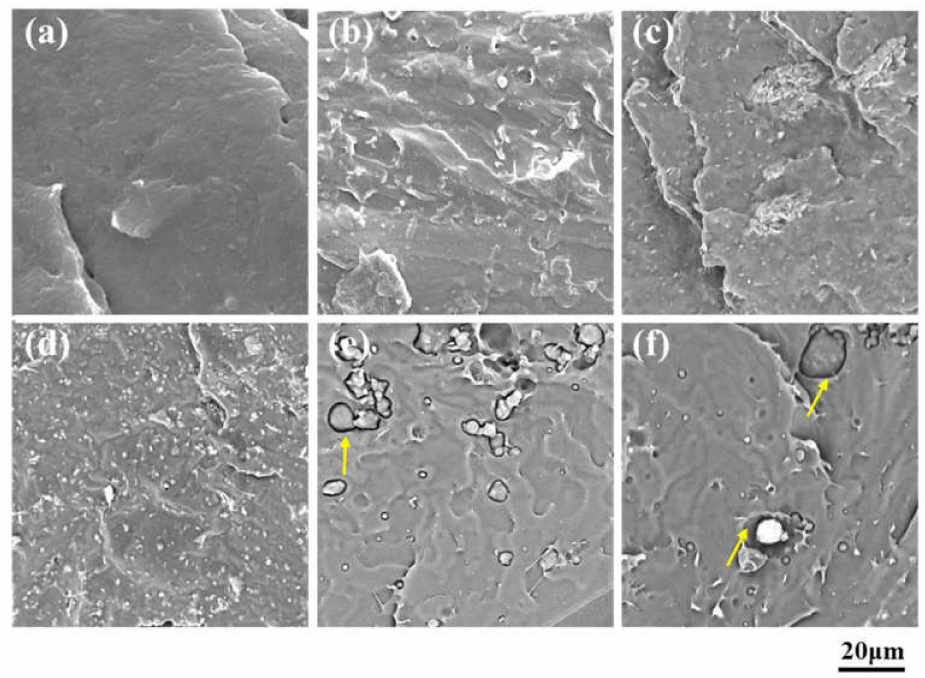
Figure 2. SEM images for the fractured surfaces of ( a ) neat PLA, ( b ) PLA/OMMT, ( c ) PLA/PVA1/OMMT, ( d ) PLA/PVA3/OMMT, ( e ) PLA/EVOH1/OMMT, and ( f ) PLA/EVOH3/OMMT.